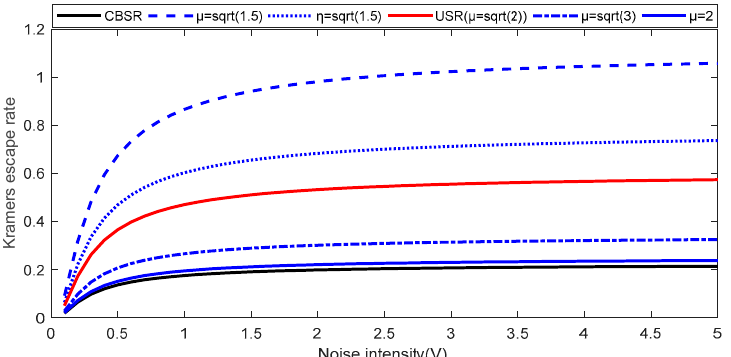
Figure 2. Kramer’s escape rate results via three different methods with parameter μ .